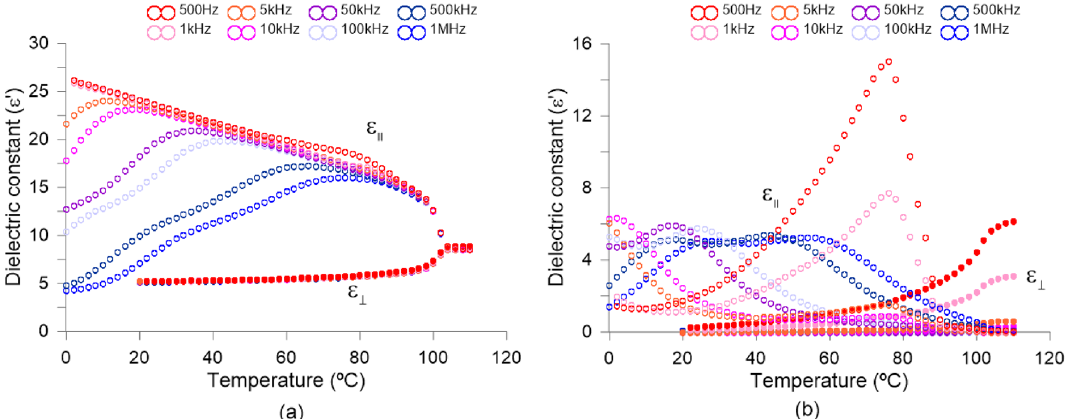
Figure 6. Temperature dependence of complex relative permittivity. ( a ) Real ( ε ′ ) and ( b ) imaginary ε ′′ .